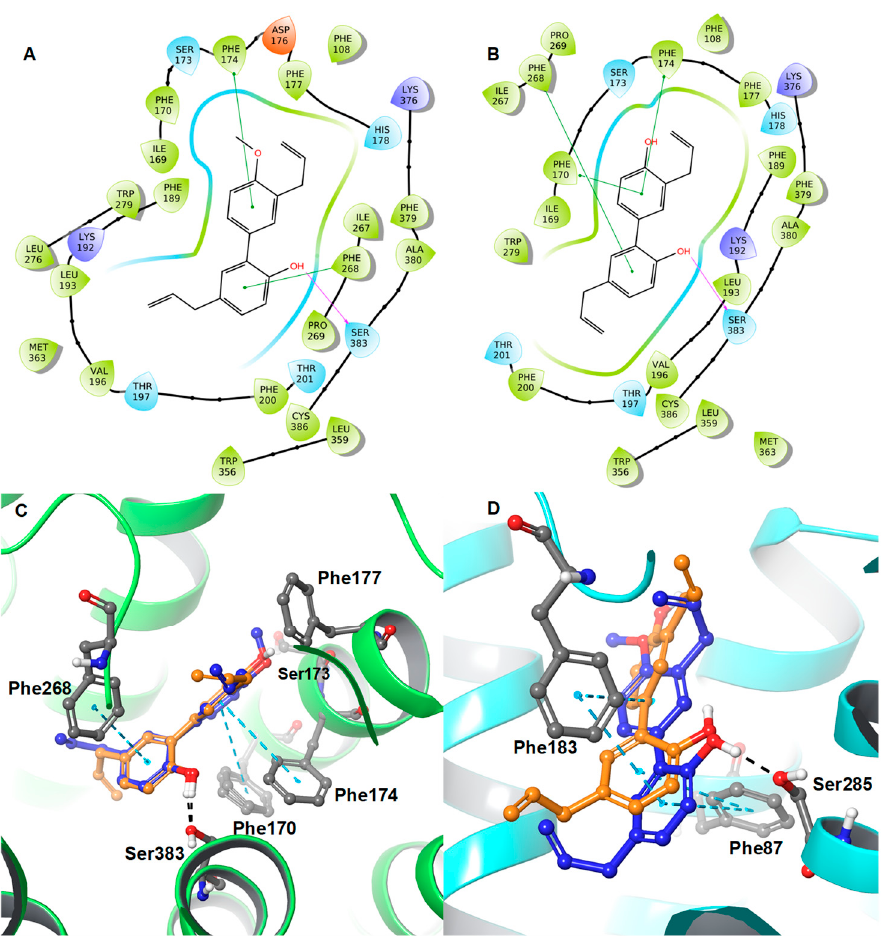
Figure 8. 2D interaction diagrams of ( A ) 1 and ( B ) 3 along with the 3D overlaid representations of ( C ) 1 (carbon in blue) with 3 (carbon in orange) against the CB1R and ( D ) 1 (carbon in blue) with 3 (carbon in orange) against the CB2R. The key residues are shown in the ball and stick model (carbon in grey).